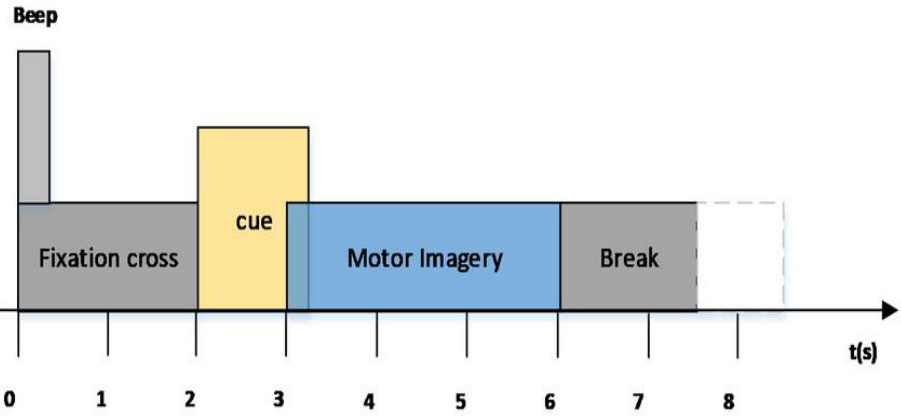
Figure 2. The time course of a single trial in the Brain Control Interface (BCI) competition IV dataset